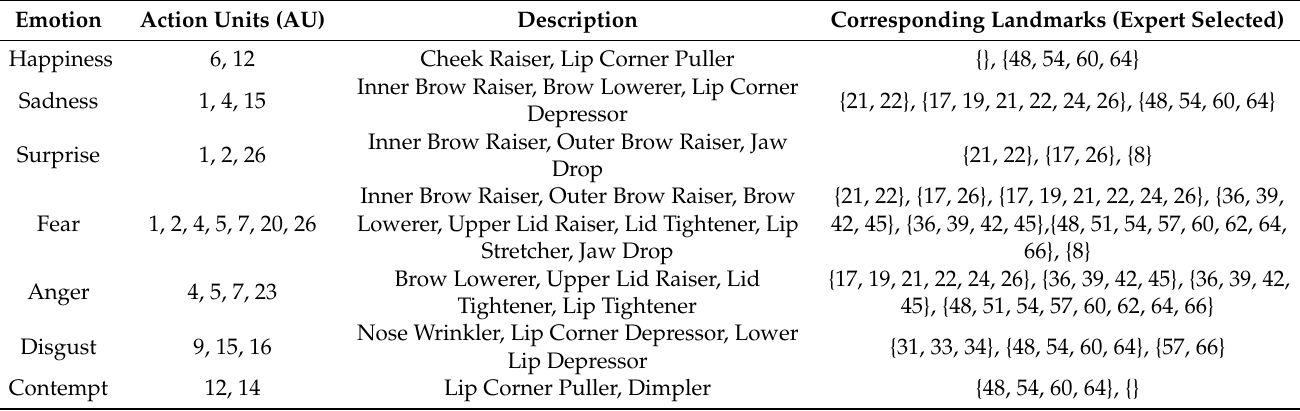
Table 6. Association of specific emotions with facial actions units and ultimately with facial landmarks points. Emotion Action Units (AU) Description Corresponding Landmarks (Expert